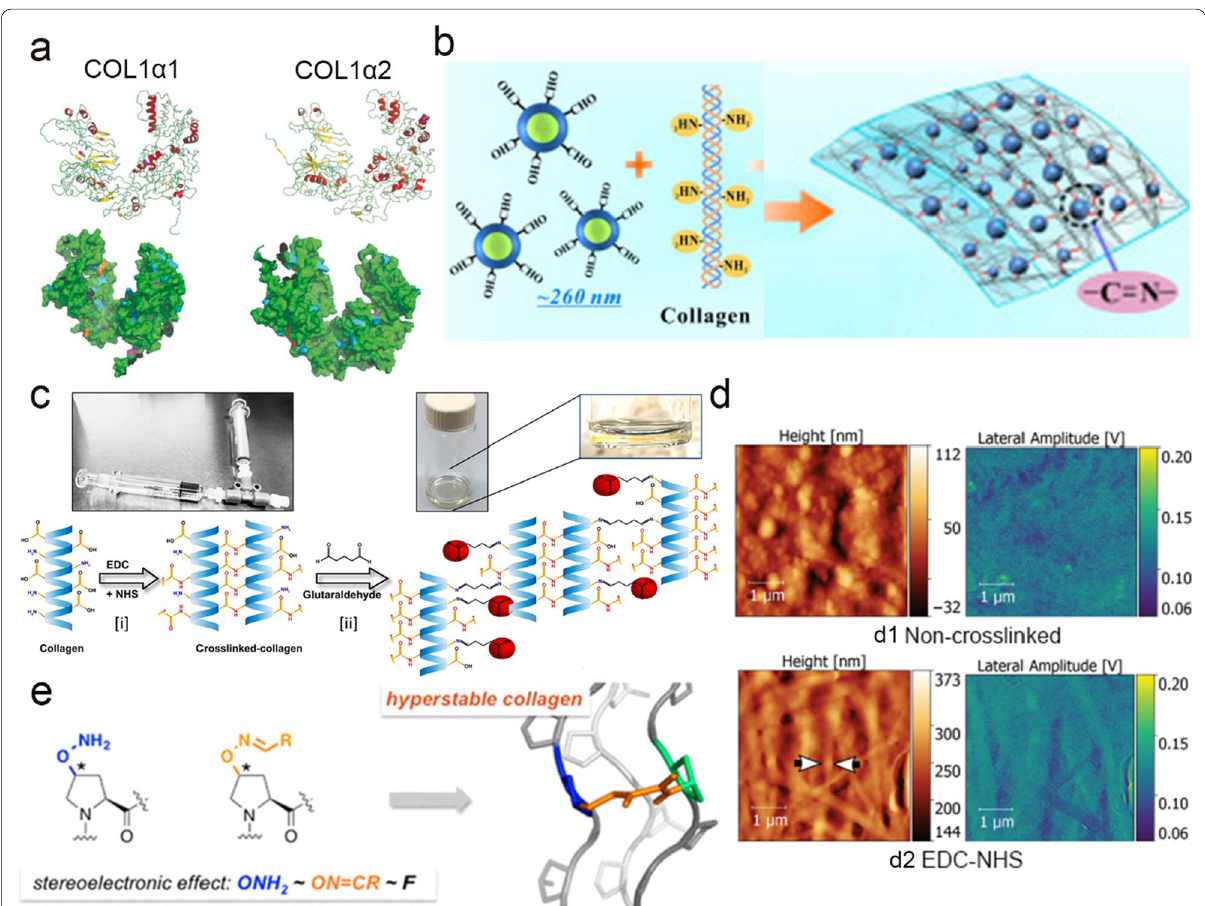
Fig. 2 Cross-linked collagen. a Localization of modified amino acids in the 3D-structure of COL BS modified biopolymers using the I-TASSER server. Reproduced with permission from [65]; b A new strategy of dialdehyde starch-based nanoparticles were developed to crosslink collagen. Reproduced with permission from [66]; c Stepwise illustration of the chemical reactions in the development of the effectivity of double-crosslinking with both EDC and GTA. Reproduced with permission from [67]; d Topographical, lateral amplitude of d1 non-cross-linked d2 cross-linked with EDC-NHS. Reproduced with permission from [68]; e collagen model peptides cross-linked by oxime bonds between 4-aminooxyproline and 4-oxoacetamidoproline. Reproduced with permission from